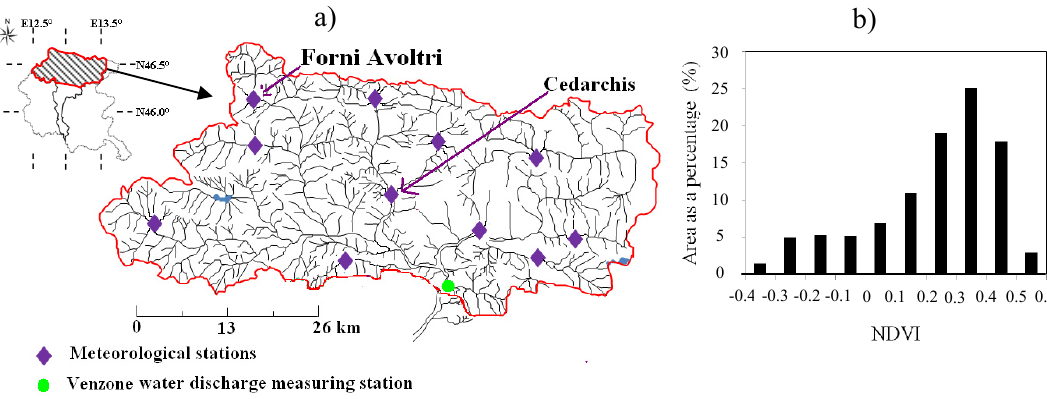
Fig. 1. (a) Catchment area representative of the Venzone water discharge measuring station and the distribution of meteorological stations within the study area. (b) NDVI composition of the catchment area derived from Landsat images taken on 29 July